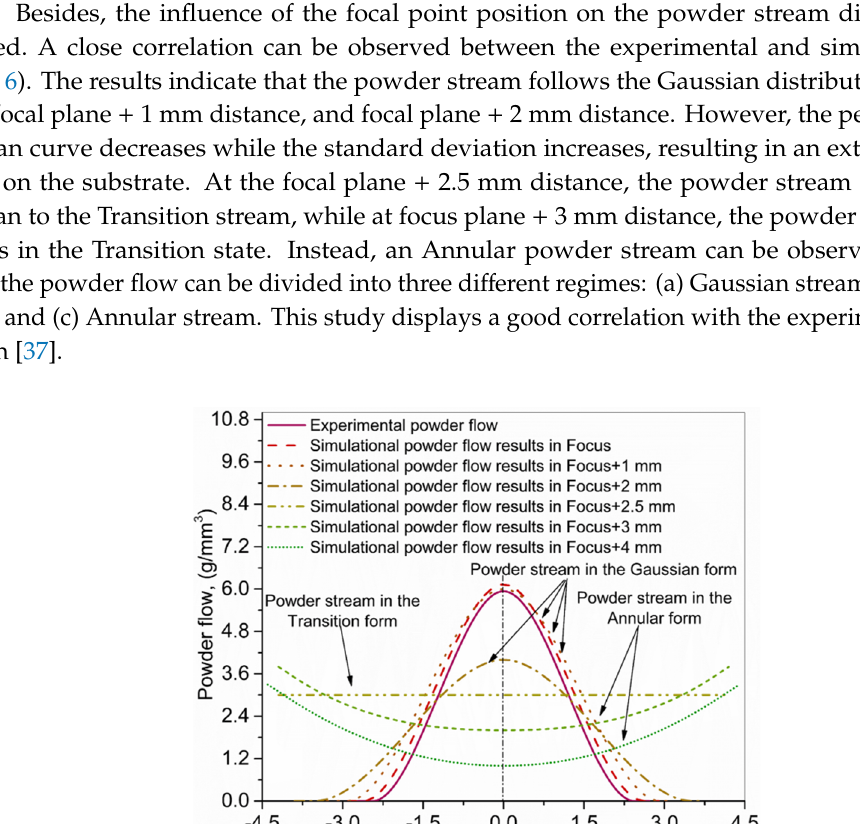
Figure 5. Ti6Al4V alloy gaussian powder stream distribution plots ( a ) 3D and ( b ) 2D.